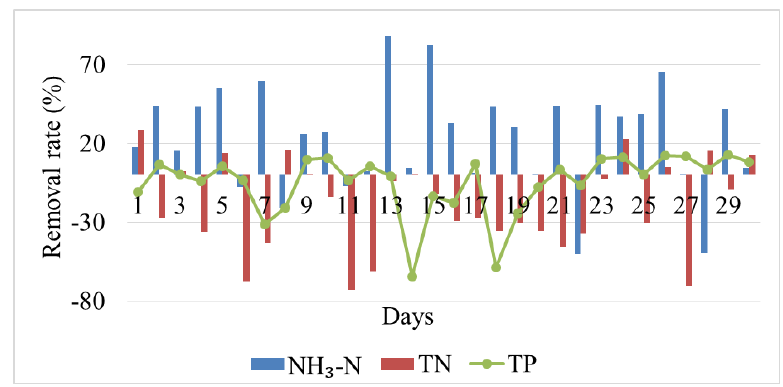
Figure 3. Effect of ozone dosage on the color removal rate (initial color at 125 times) .